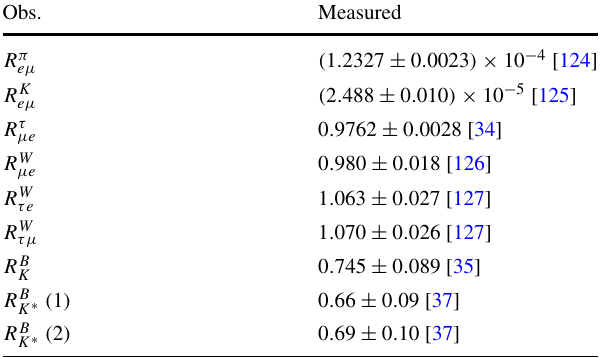
Table 4 Experimental values of ( V CKM ) us and the average value of (